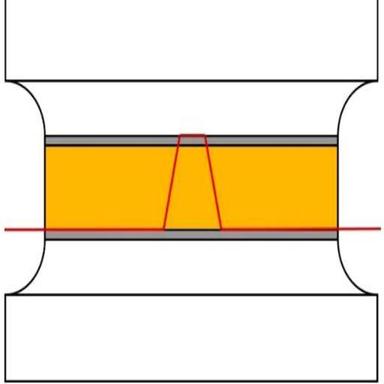
(a) anomalous fracture surfaces after torsion for some THG-5 GC2 joined sample tested at room temperature: (b) fracture propagation sketch (orange = glassceramic; grey = oxide scale; red = fracture propagation) with GC2 present mostly on one fracture surface, as observed by SEM-EDS in (c) with each region identified (For interpretation of the references to colour in this figure legend, the reader is referred to the web version of this article.).